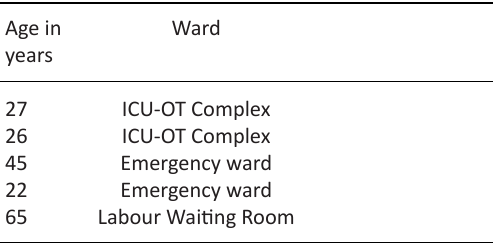
Table 4. Distribution of MRSA isolates: Age of visitors